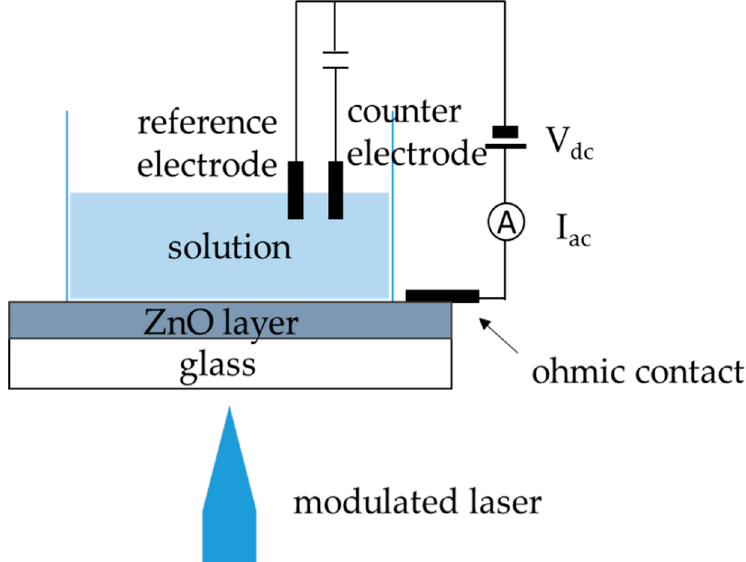
Figure 1. Schematic of a simplified LAPS